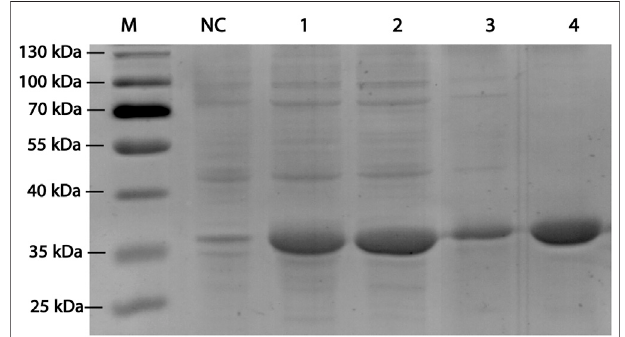
FIGURE 3 | SDS-PAGE analysis for RpDAE cloned in pET-21a (+) and expressed in E. coli BL21 (DE3). Lane M, protein marker; Lane NC, Cell lysate withoutinduction;Lane1,celllysatewithinduction;Lane2,supernatantofcell lysate with induction; Lane 3, debris of cell lysate with induction; Lane 4, puri fi ed protein.